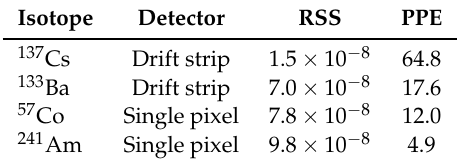
Table 2. RSS and PPE values for each deconvoluted spectra reported in this